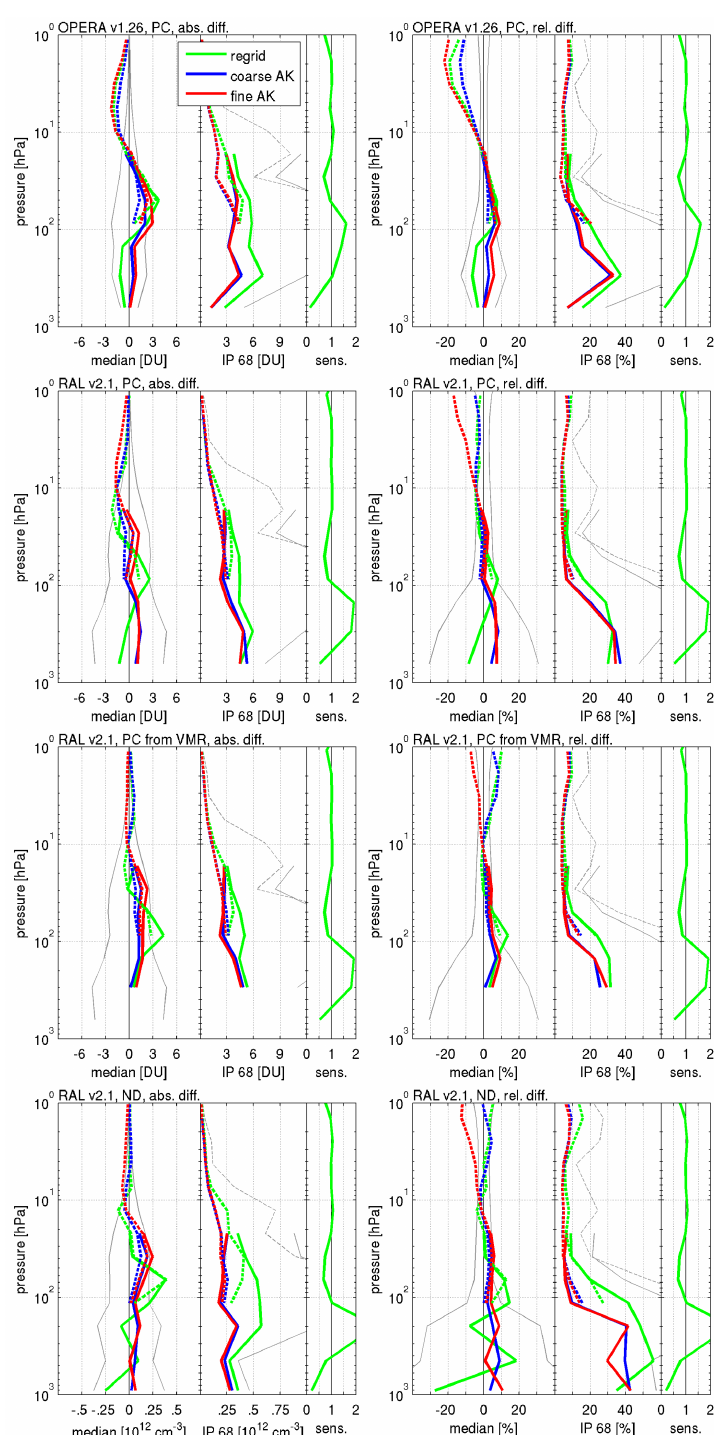
Figure 8. Ground-based comparison results for GOME-2 2008 (from top to bottom) OPERA v1.26 in partial columns (PC), RAL v2.1 in partial columns, RAL v2.1 in partial columns determined using RAL’s high-resolution VMR integration method, and RAL v2.1 number densities (ND). Absolute and relative difference statistics are grouped in the left and right column, respectively. Full lines are for ozonesonde differences, dashed lines for lidar comparisons, with green, blue, and red colours for regridded, coarse resolution AK smoothed, and fine resolution AK smoothed ground-based data, respectively. Light grey lines indicate satellite and combined uncertainties for bias and spread evaluation (see main text). The median sensitivity is also added to each